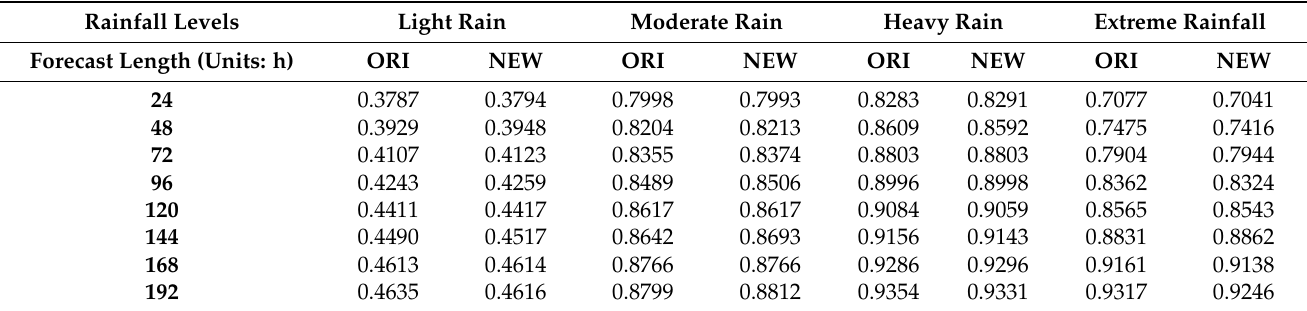
Table 7. POFA of precipitation at different rainfall levels over East